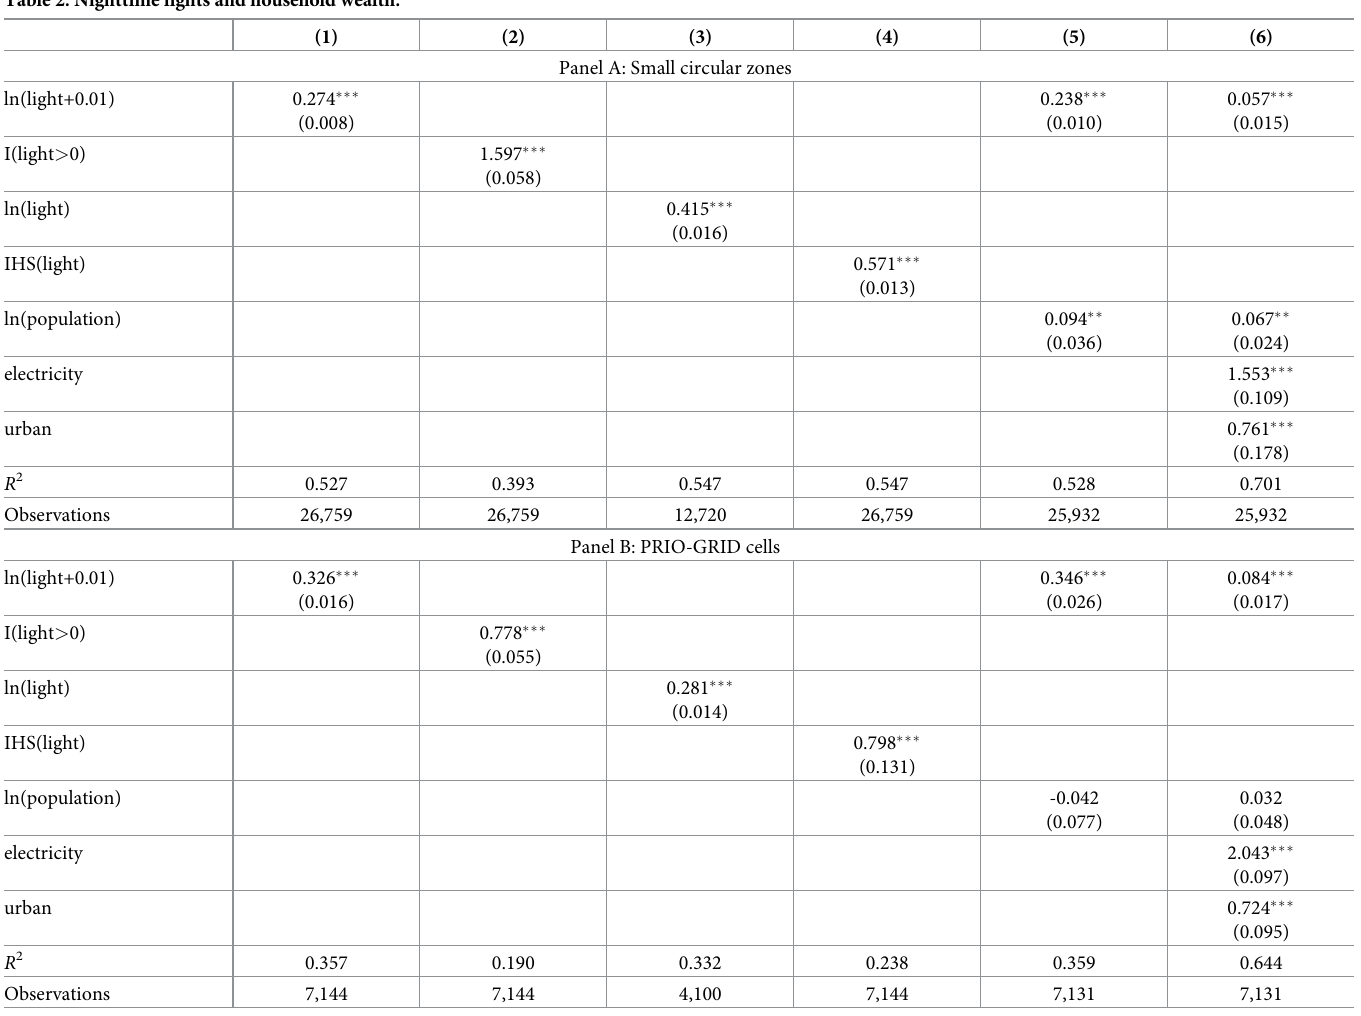
Table 2. Nighttime lights and household